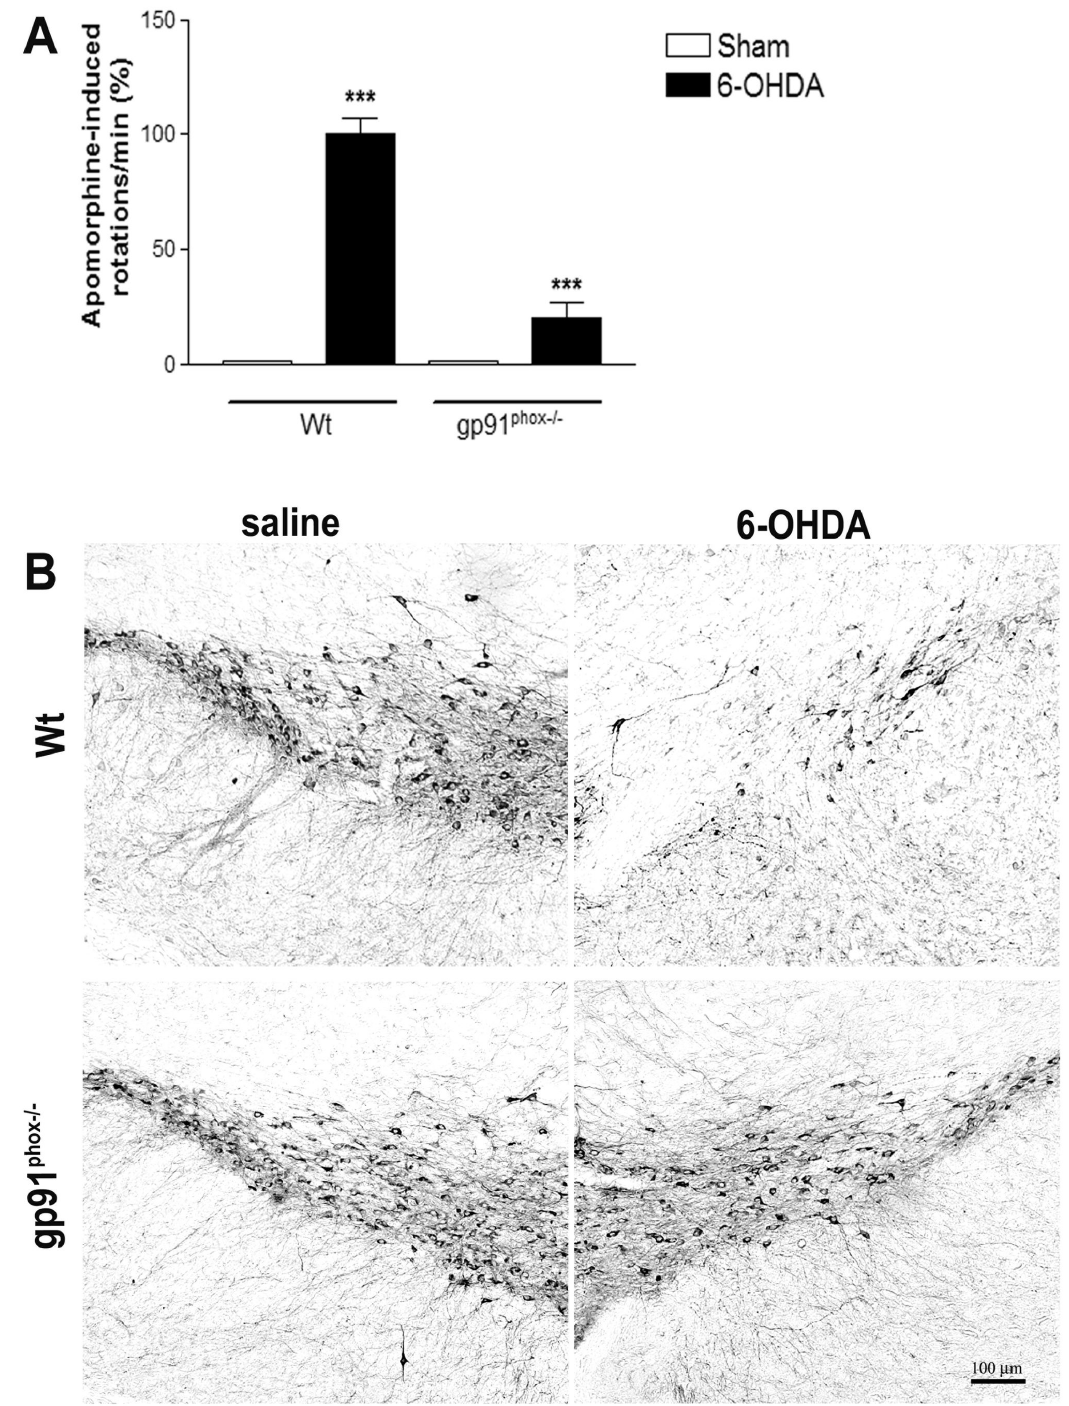
Figure 2. NADPH oxidase is involved in the 6-OHDA-mediated degeneration of DA neurons in SN. A, apomorphine-induced contralateral rotations evaluated at 14 days post-PD induction in Sham, Wt 6-OHDA-lesioned mice and gp91 phox-/- 6-OHDA lesioned mice groups; n=12. Values are expressed as percent of induced rotations/min in relation to the Sham group. Representative digital images demonstrating TH-immunoreactive cell bodies in the SN of Wt saline, Wt 6-OHDA and gp91 phox-/- 6-OHDA-lesioned mice groups (B). Images are representative of at least six independent experiments. The statistical significance is expressed as: *** P<0.001 versus Wt Sham group and *** p<0.001 gp91 phox-/- 6-OHDA versus Wt 6-OHDA. doi: 10.1371/journal.pone.0075532.g002 PLOS ONE |